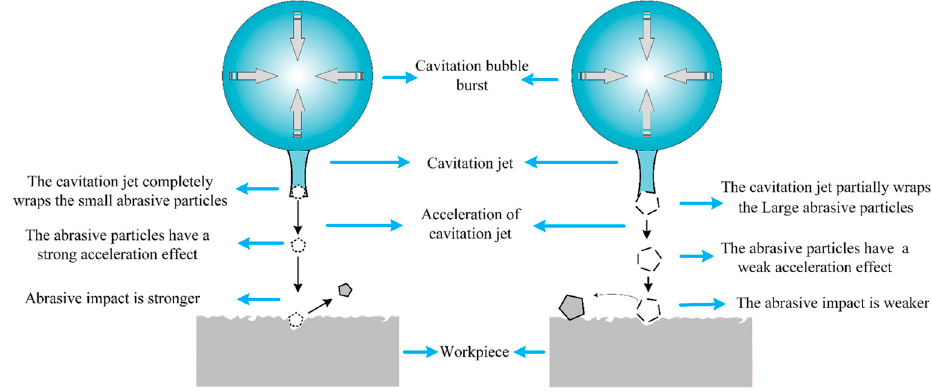
Figure 13. Diagram of cavitation jets acting on abrasive particles of different sizes.